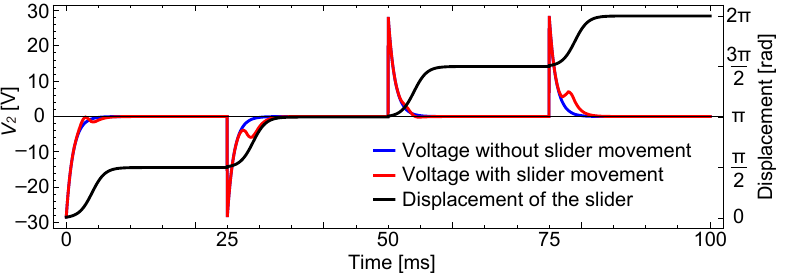
Figure 7. Analytical results with the capacitance imbalance. The parameter b for describing the imbalance was set to